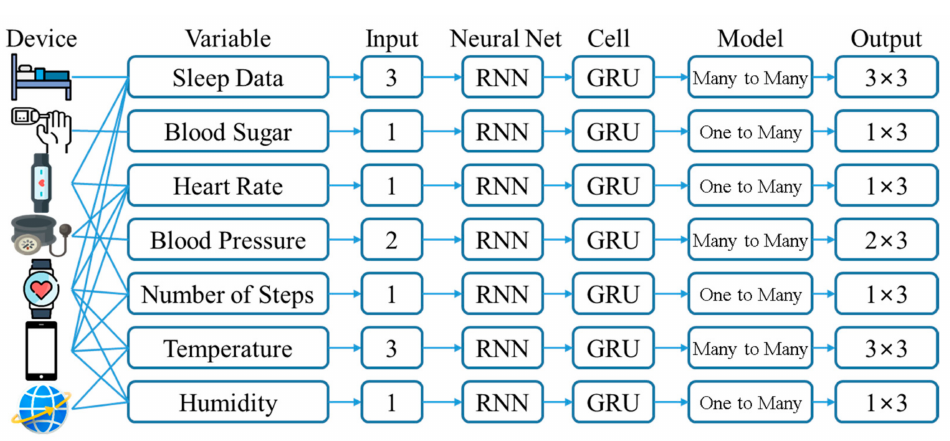
Figure 3. GRU cells-based RNN learning according to